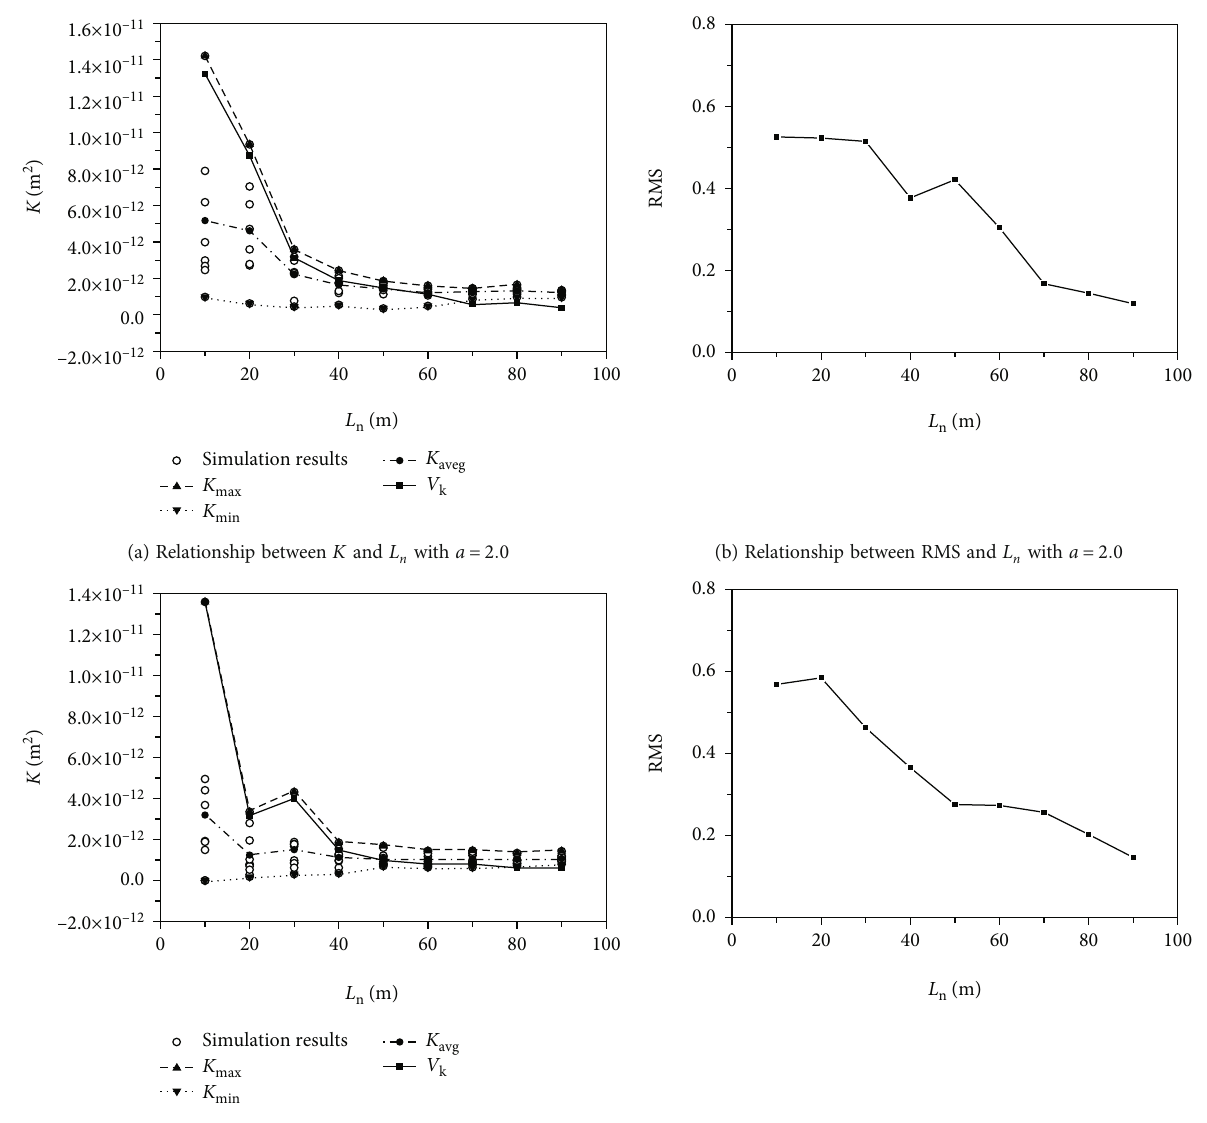
(d) Relationship between RMS and L n with a = 2 : 5 Figure 11: